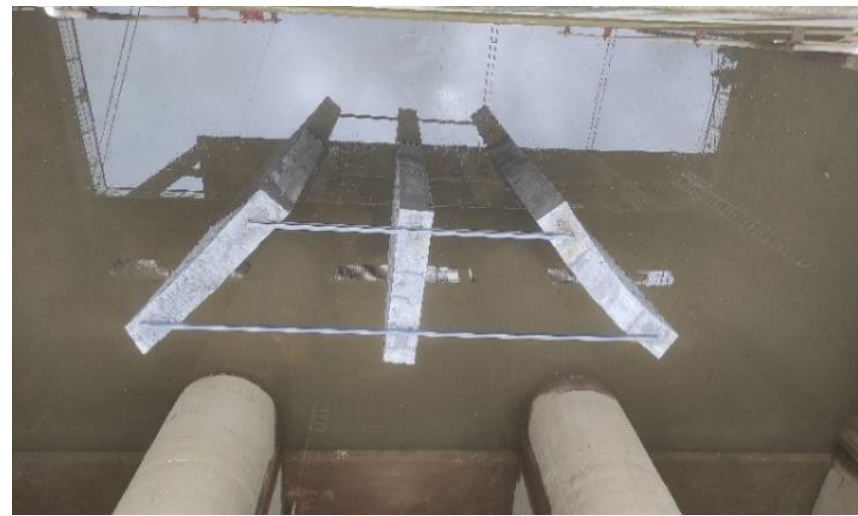
Figure 21 Completion diagram of transformation. Figure 21. Completion diagram of transformation.